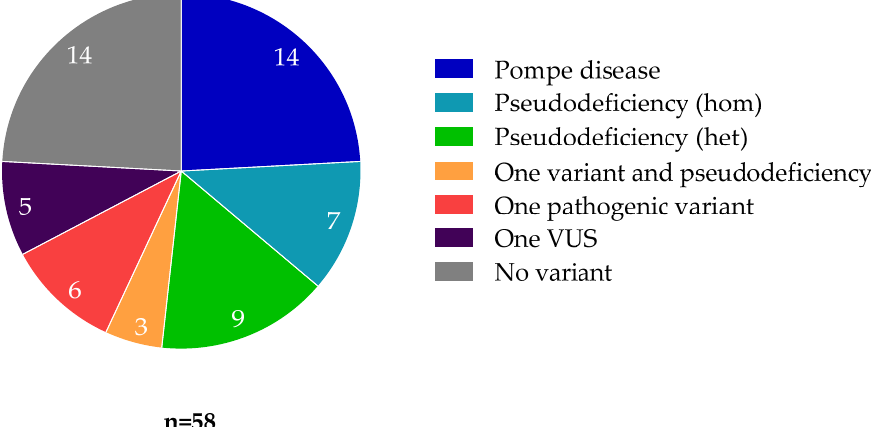
Figure 1. Genotype-based categories of patients with decreased acid alpha-glucosidase activity. Pompe disease—2 pathogenic or likely pathogenic GAA variants identified. Pseudodeficiency (hom)— One known pseudodeficiency allele was identified in a homozygous state, in the absence of any other identified variant. Pseudodeficiency (het)—One known pseudodeficiency allele was identified in a heterozygous state, in the absence of any other identified variant. One variant + pseudodeficiency— A single variant (pathogenic or of uncertain significance was identified in a heterozygous state, together with at least one known pseudodeficiency allele. One pathogenic variant—A single pathogenic or likely pathogenic variant was identified. One VUS—A single heterozygous variant of uncertain significance was identified. No variant—No variant of any kind was identified in the GAA gene.